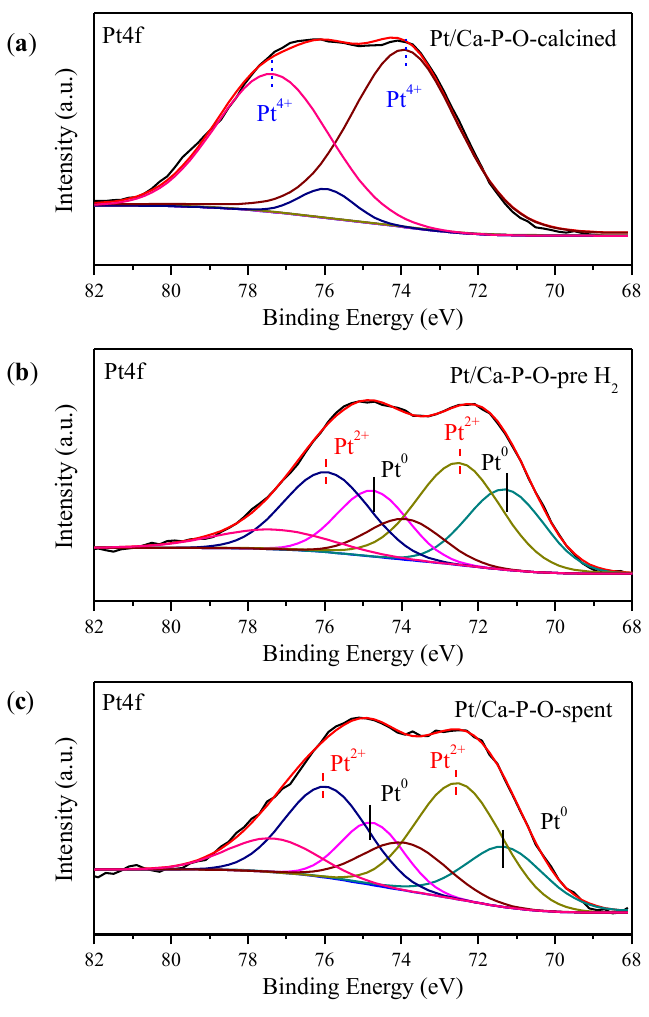
Figure 9. Pt4f XPS data of Pt/Ca-P-O calcined at 500 °C ( a ); Pt/Ca-P-O calcined at 500 °C and then pretreated in 4% H 2 at 300 °C ( b ); and Pt/Ca-P-O collected after reaction ( c ).